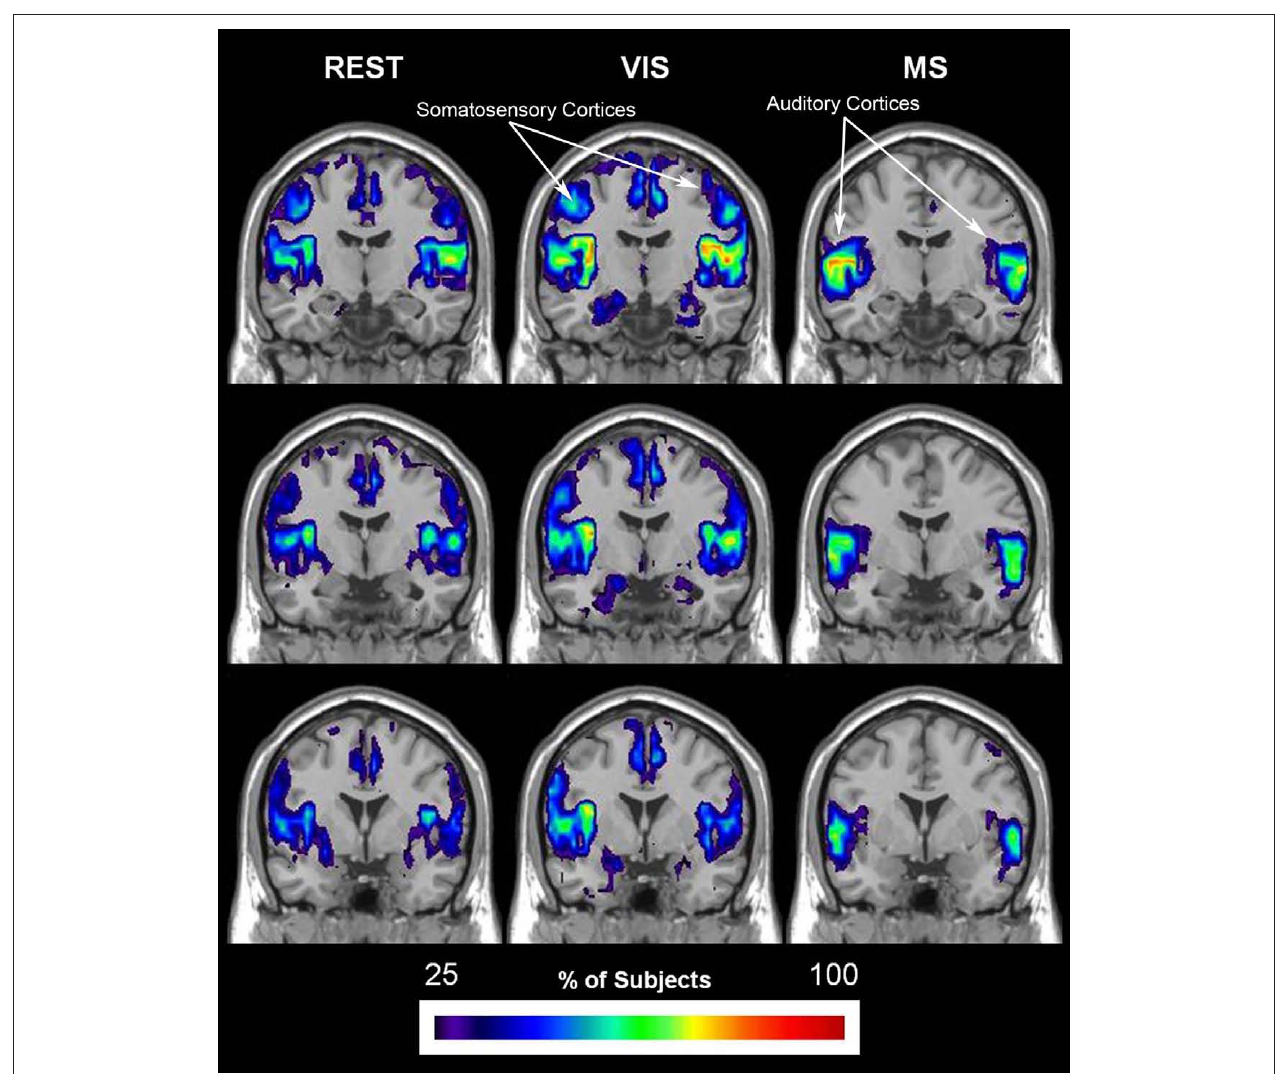
degree of overlay between these maps is indicated by the threshold color bar, which represents the percentage of participants. The spatial extent of the auditory module across tasks is shown to become more specific to both primary and secondary auditory cortices in the multisensory condition (MS). These modules, on the other hand, show less specificity to the auditory cortices in the conditions that do not have auditory stimulation: rest (REST) and